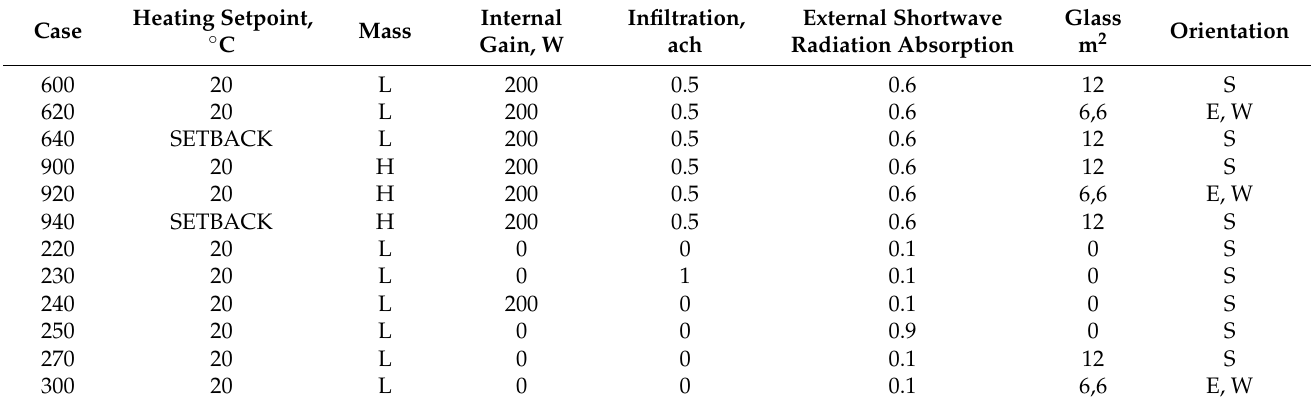
Table 3. Case Descriptions.